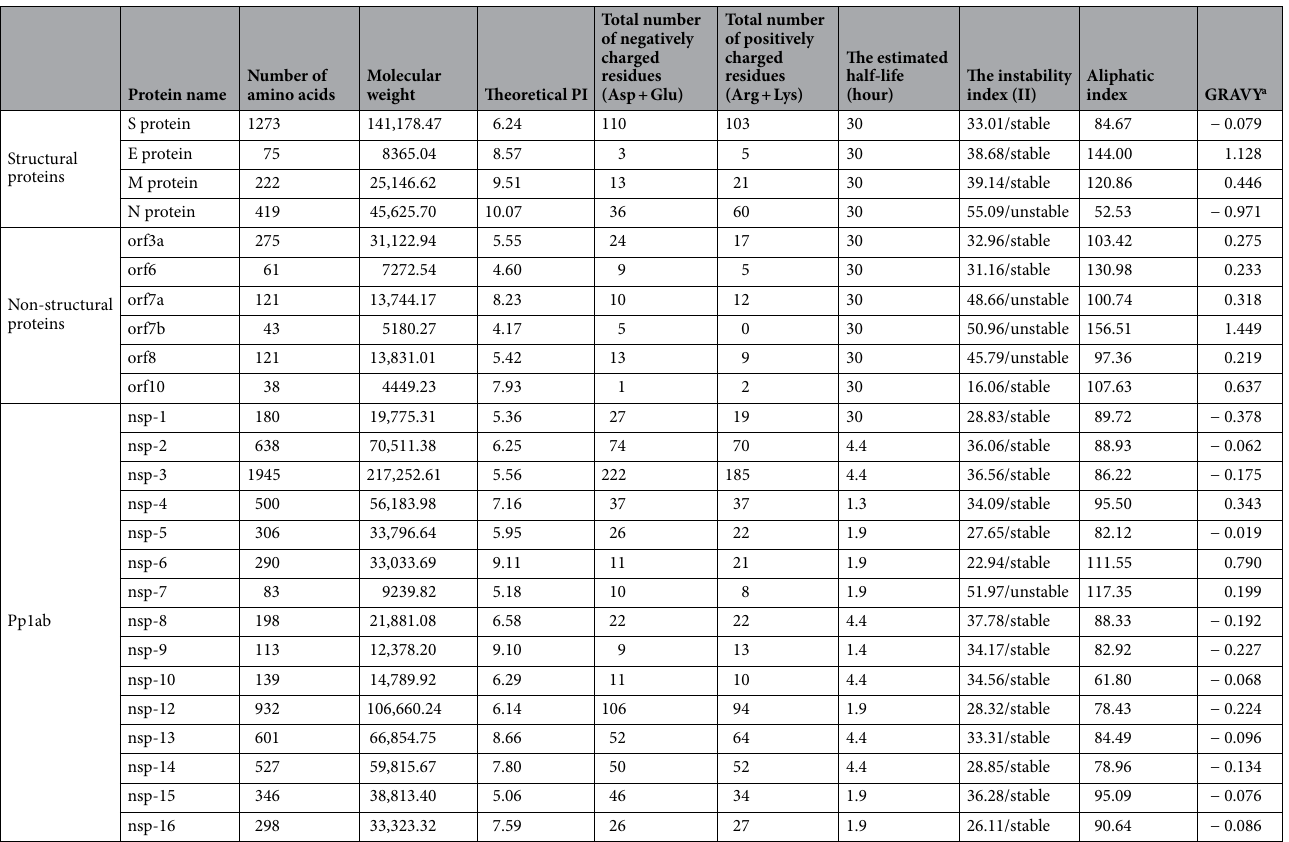
Table 1. Physico-chemical parameter results predicted by ExPASyProtParam. a GRAVY means the Grand average of